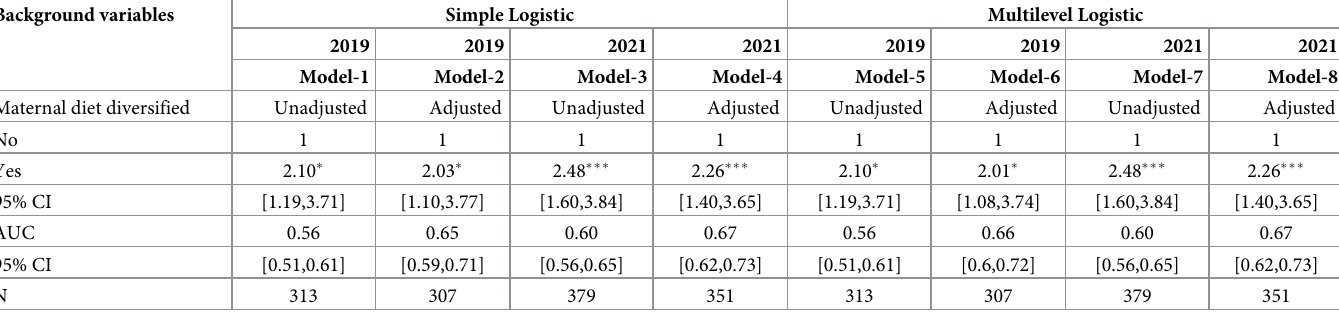
Note: The models are adjusted for demographic and socioeconomic characteristics of mother and children (S4